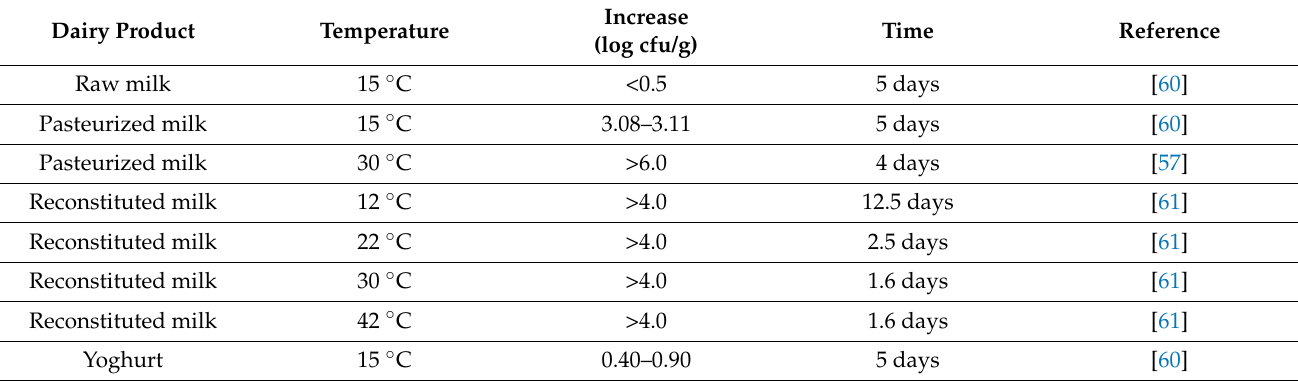
Table 3. Growth ability of B. cereus in different milk and milk